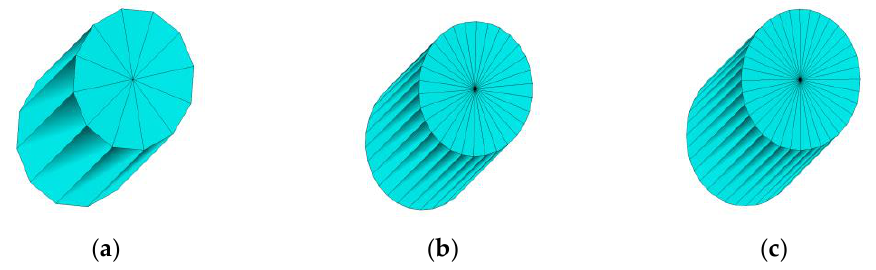
Figure 5. Variation in number of singular elements at the crack tip, ( a ) 12 equal parts ( b ) 30 equal parts ( c ) 36 equal parts.